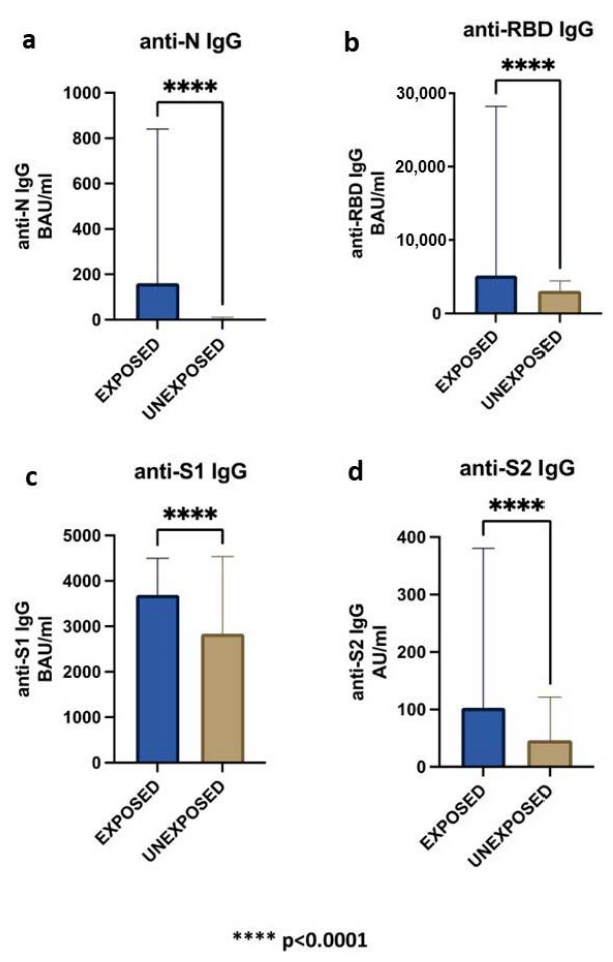
Figure 2. Comparison between exsposed and unexsposed HCWs groups for: anti-N IgG ( a ), anti- RBD IgG ( b ), anti-S1 IgG ( c ) and anti-S2 IgG ( d ). 2.3. Trend of the Antibody Levels during the Time, Clinical Symptoms, and Presence of